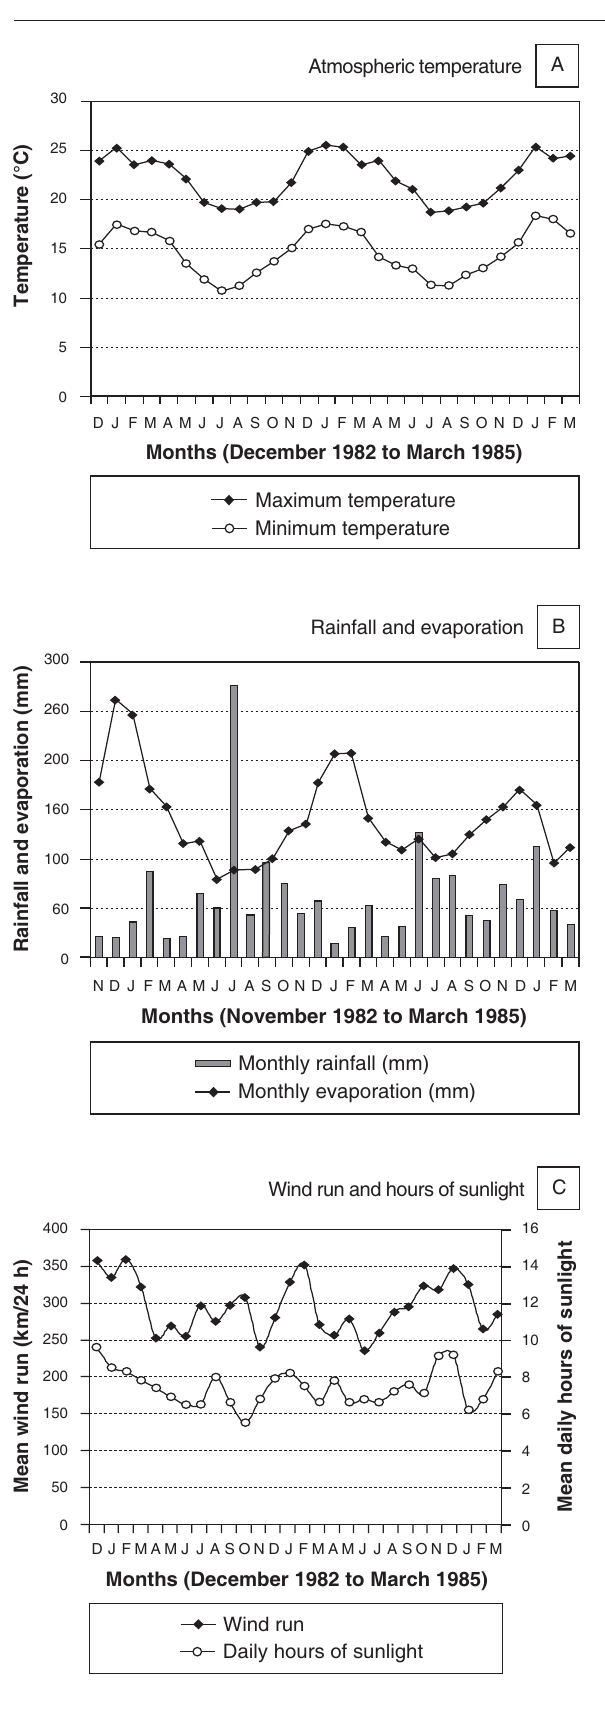
occurrence of larvae on the herbage, but rather